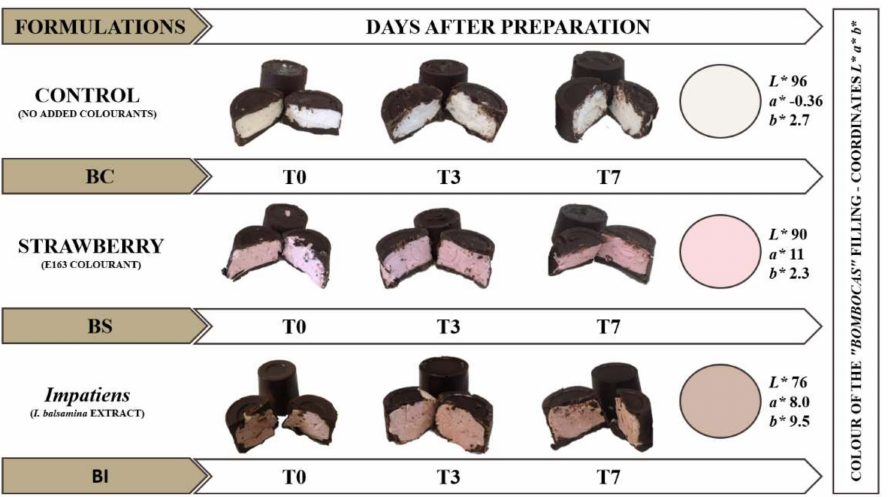
Figure 1. Formulations of “bombocas” made and final colouration of the filing obtained by the coordinates L * a * b * (created by the